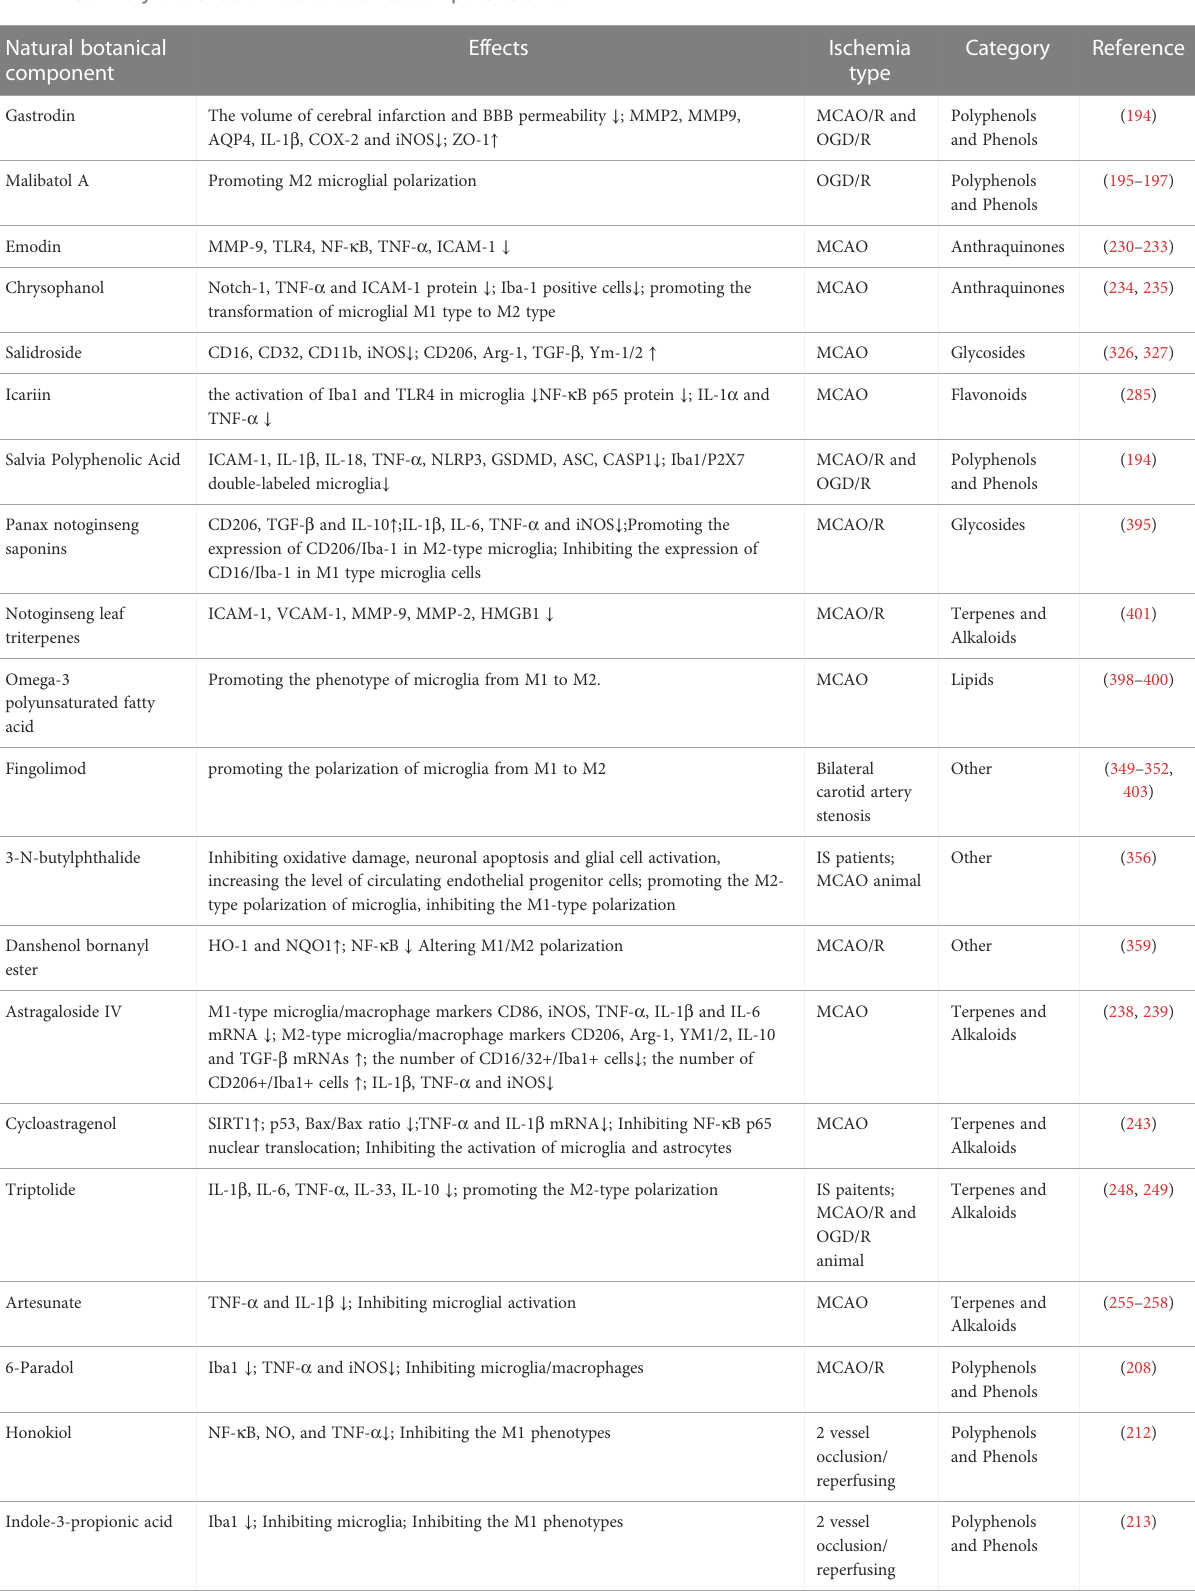
TABLE 1 Summary of the role of natural botanical components on IS. Natural